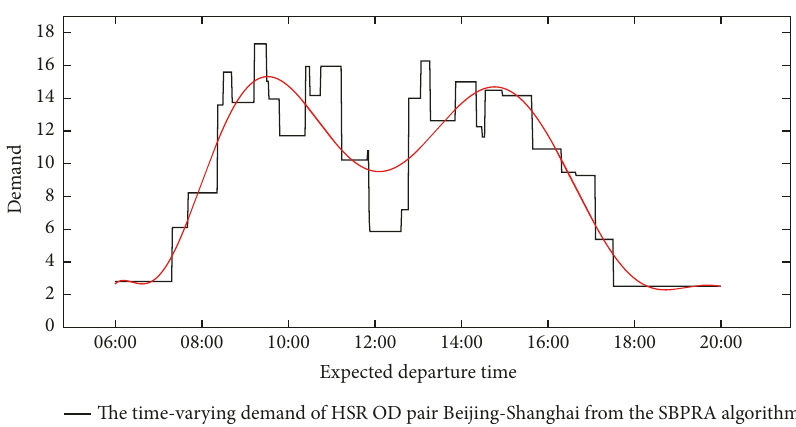
The time-varying demand of HSR OD pair Beijing-Shanghai from the SBPRA algorithm Figure 8: Polynomial fitting for the time-varying demand from the SBPRA algorithm. Table 5: The time-varying demand from the SBPRA algorithm .